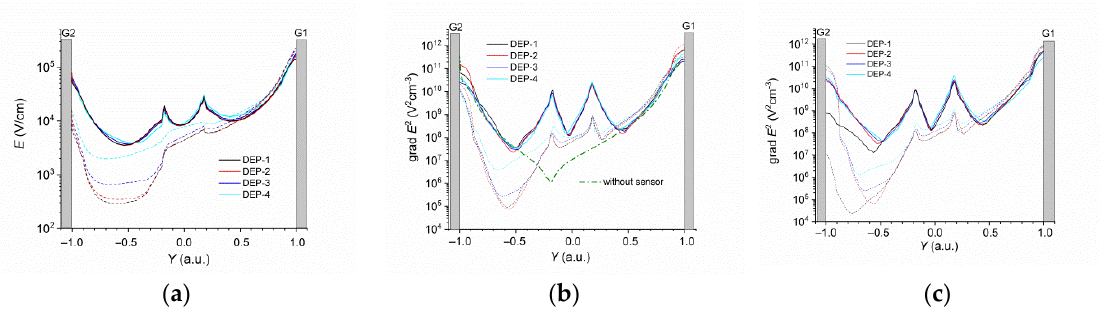
Figure 4. ( a ) Dependencies of E(Y); ( b , c ) dependencies of grad E 2 (Y) calculated at Z = 30 nm in the cross sections of ( b ) B and ( c ) C; V bg = 0.5 V (straight lines) and V bg = − 0.5 V (dashed lines). The dash-dotted line in ( b ) is the case of DEP-2 electrodes without sensor, V bg = 0.5 V. H G = 100 nm. L = 1.2 mkm.